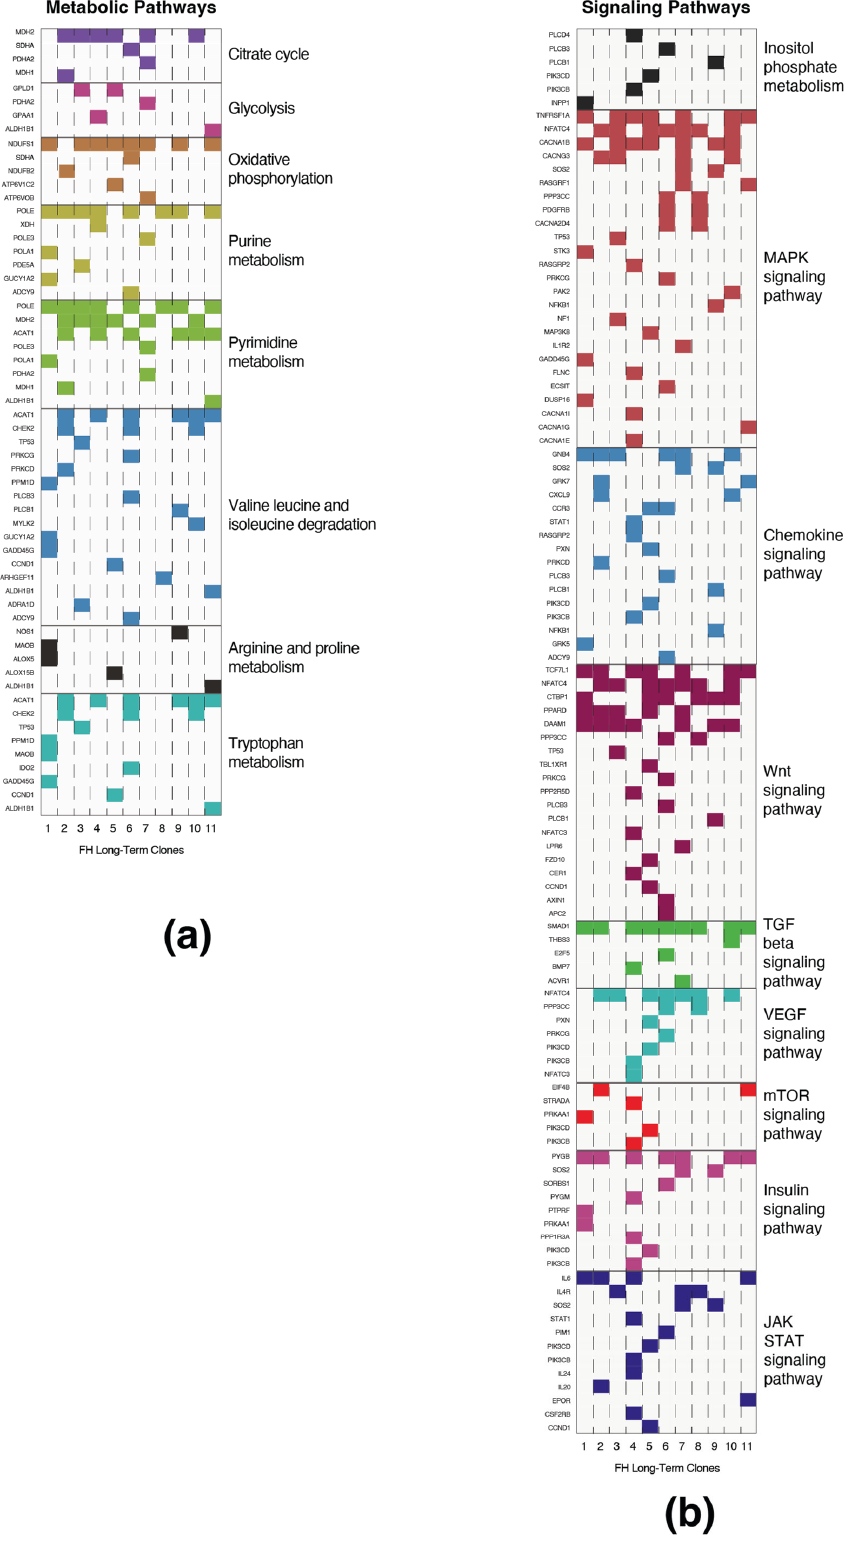
Figure 4. Long-term FH loss is accompanied by mutations in selected signaling and metabolic genes. ( a ) The mutated genes are presented as metabolic pathways. Each column represents a different FH-KO clone, and each row represents a different gene. The different pathways are color-coded and determined by the KEGG database. ( b ) The names of selected signaling pathways are color labeled as in